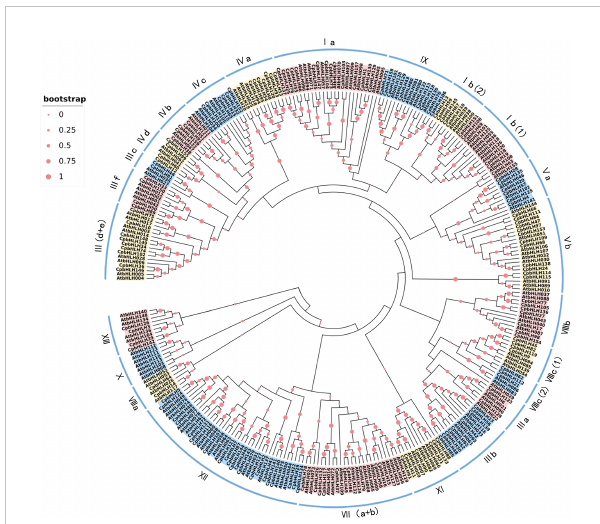
FIGURE 4 Phylogenetic tree and classi fi cation of bHLH subfamily proteins in A. thaliana and C. paliurus . The number of bHLH proteins of A. thaliana and C. paliurus is 140 and 159, respectively. The red dots represent boot values — the larger the dot, the larger the bootstrap value. Roman numerals line up with the bHLH